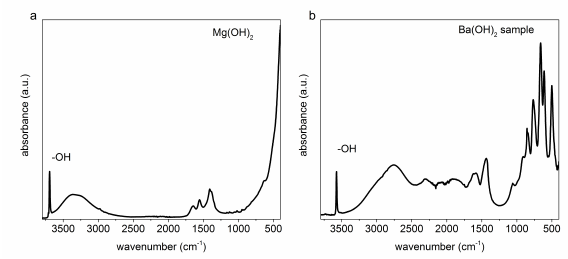
Figure 2. a) FTIR spectrum of Mg(OH) b) FTIR spectrum of Ba(OH)